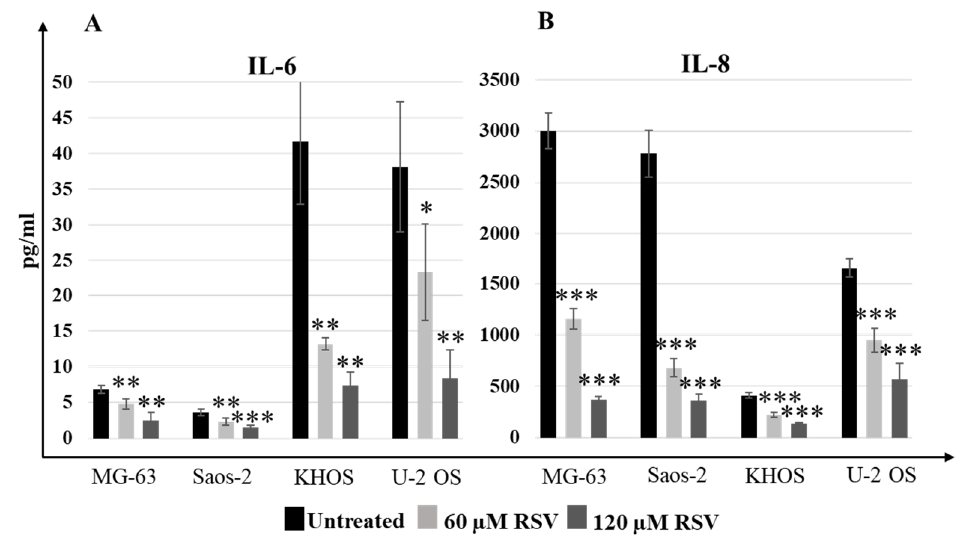
Figure 6. Treatment with RSV reduced IL-6 and IL-8 secretion levels in OS cell lines. The ELISA assay results showed how IL-6 ( A ) and IL-8 ( B ) levels (pg/mL) decreased after 48-h RSV treatment (mean ± SD). Baseline expression of this proinflammatory cytokine was different in each OS cell line, but the decrease in IL-6 levels was observed for each OS cell line. A one-way ANOVA test was used to evaluate the effect of RSV treatment factor (60 and 120 µ M) on IL-6 release (MG-63—F = 27.4, p < 0.0005; Saos-2—F = 34.7, p < 0.0005; KHOS—F= 53.6, p < 0.0005; U-2 OS—F = 24.3, p < 0.0005) and on IL-8 (MG-63—F = 583, p < 0.0005; Saos-2—F = 315, p < 0.0005; KHOS—F = 155, p < 0.0005; U-2 OS—F = 102, p < 0.0005). Dunnett’s test: *, p < 0.05, **, p < 0.005, ***, p < 0.0005 versus untreated cell culture.